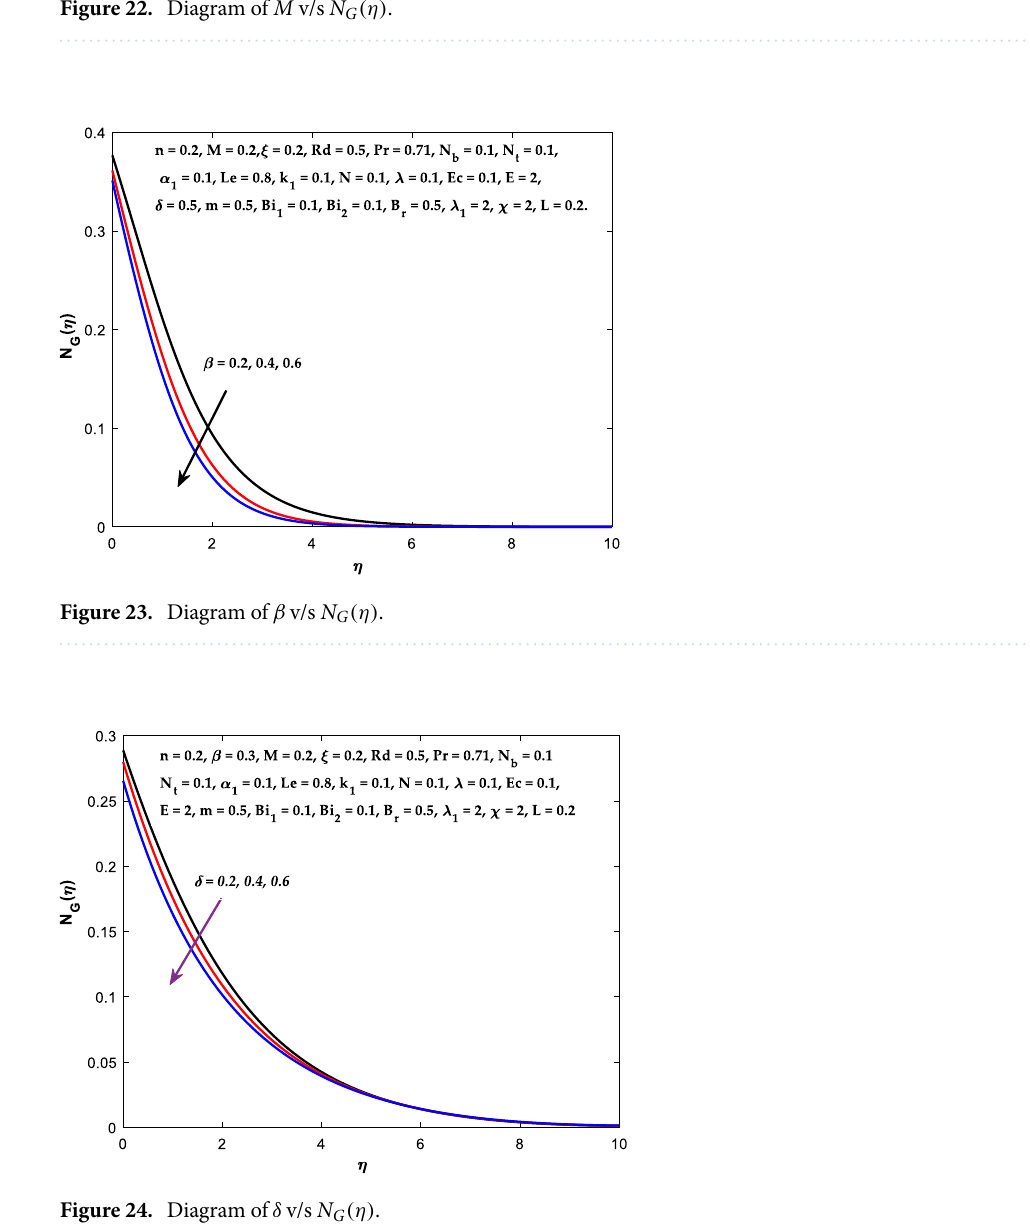
Figure 22. Diagram of M v/s N G (η) .